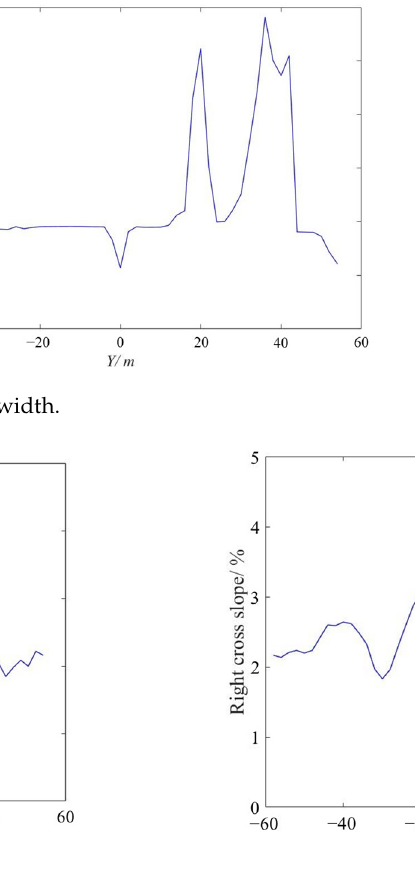
Figure 12. Longitudinal gradient.